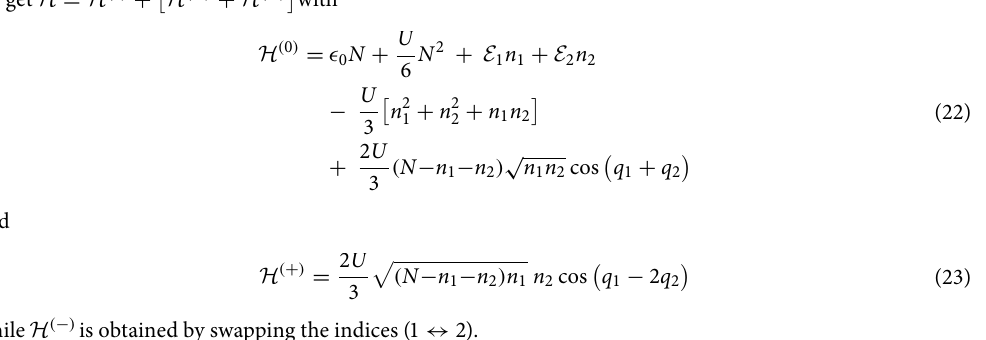
Figure 8. The Bogolyubov frequencies. They are calculated for a k left to right are for (cid:31) stb , and (cid:31) dyn , and (cid:31) swp . The latter cannot be deduced form the Bogolyubov analysis, but requires global understanding of phase space